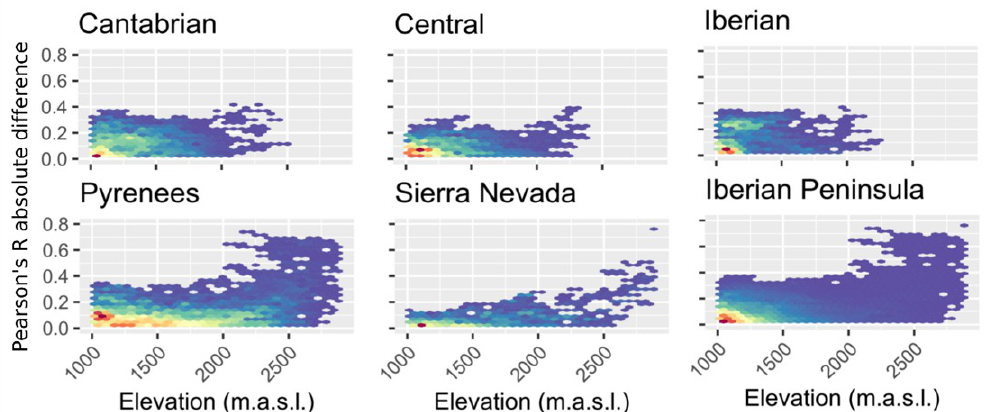
Figure 4. Absolute di ff erences in the Pearson’s R statistic for correlations of the DJFM-NAO with the snow duration and the peak SWE. The colors in the scatterplots indicate the relative density of points, ranging from blue (lower relative density) to red (higher relative